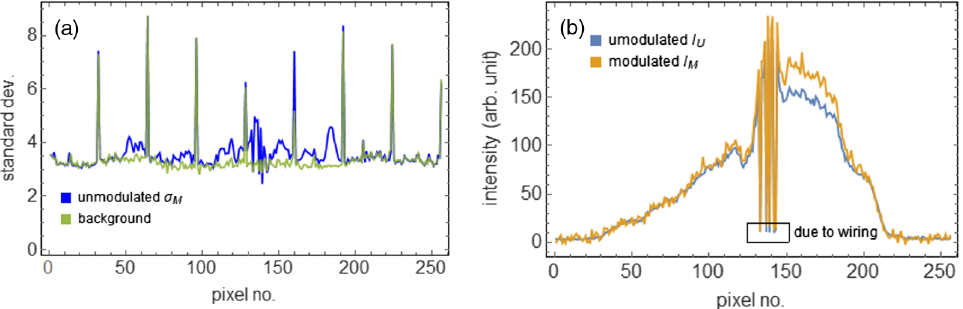
FIG. 2. (a) Standard deviation of a background signal (obtained with a blocked laser beam) and an unmodulated signal. We evaluated 100 000 measurements for both plots. (b) Averaged intensity of the same 100 000 measurements of the unmodulated laser pulse from panel A compared with a single-shot measurement of a modulated laser pulse. Both data sets were corrected by subtracting the background measured with a blocked laser